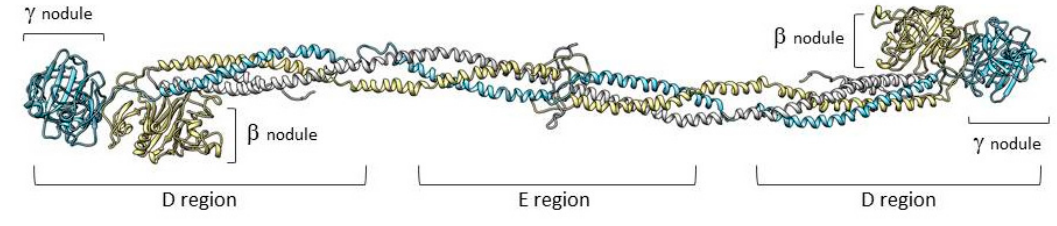
Figure 1. Representation of fibrinogen molecule based on its crystal structure [6]. The three fibrinogen chains (A α , B β , and γ ) forming the molecule are shown in white, yellow, and light blue, respectively. The peripheral portions of the D regions are composed of the globular C-terminal nodules of the β B and γ chains.